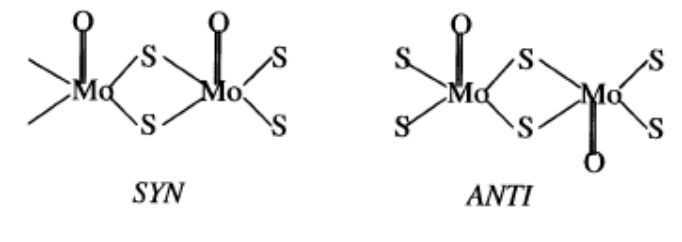
Figure 3. Possible configurations in the molybdenum oxysulfide species. Reproduced from reference [67] with permission from the American Chemical